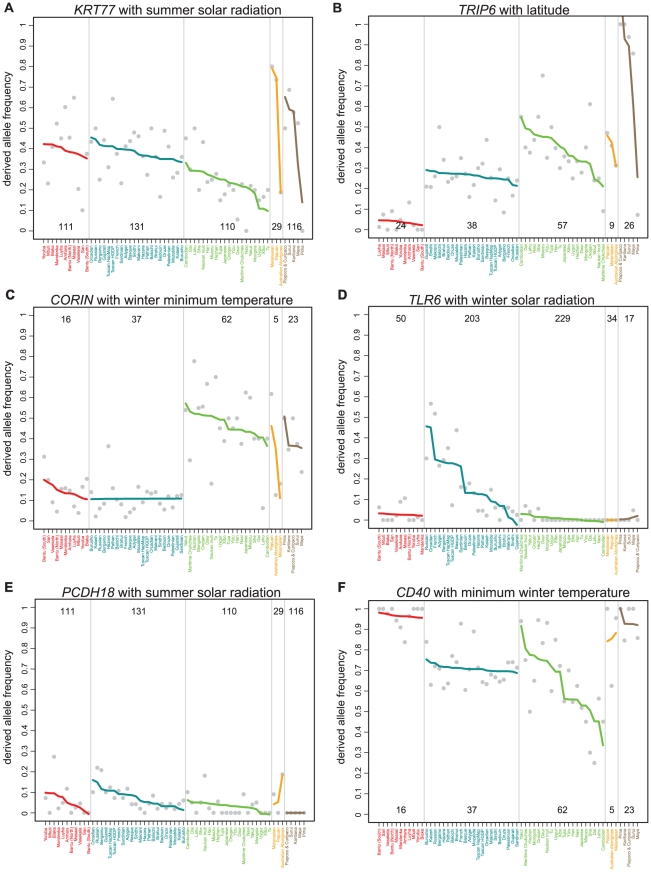
Global variation in allele frequencies for SNPs with strong signals with climate.Two NS SNPs from the worldwide analysis: (A) A SNP (rs3782489) in keratin 77 (KRT77), is strongly correlated with summer solar radiation, and (B) a SNP (rs2075756) in the thyroid receptor interacting protein (TRIP6) is strongly correlated with absolute latitude. Two SNPs from the population subset analysis: (C) A SNP (rs4558836) in CORIN has a signal in the AEA population subset with winter minimum temperature, but not in the AWE subset, and (D) a NS SNP (rs5743810) in TLR6 has a signal in the AWE population subset with winter solar radiation, but not in the AEA subset. Two SNPs that are associated with autoimmune disease from GWAS: (E) A SNP (rs2313132) upstream of PCDH18 that is associated with SLE is strongly correlated with summer solar radiation, and (F) a SNP (rs6074022) upstream of CD40 that is associated with multiple sclerosis is strongly correlated with minimum winter temperature. For each plot, gray points represent individual SNPs and colored lines represent fitted lines (obtained using the lm function in R) for each region. The ranges of the climate variable values for each region are shown at the bottom of the corresponding segment of the plot.